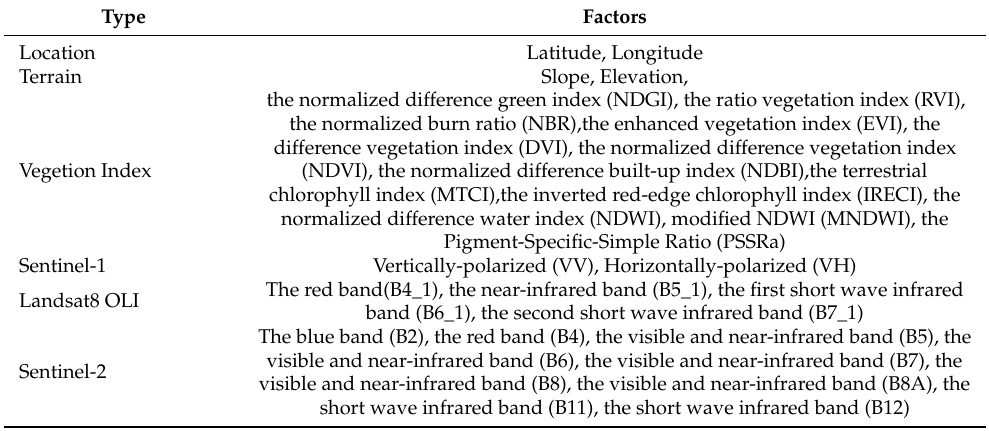
Figure 4. The random-forest canopy height estimation model, green circle means target feature, white circle means other feature. Table 2. Candidate feature